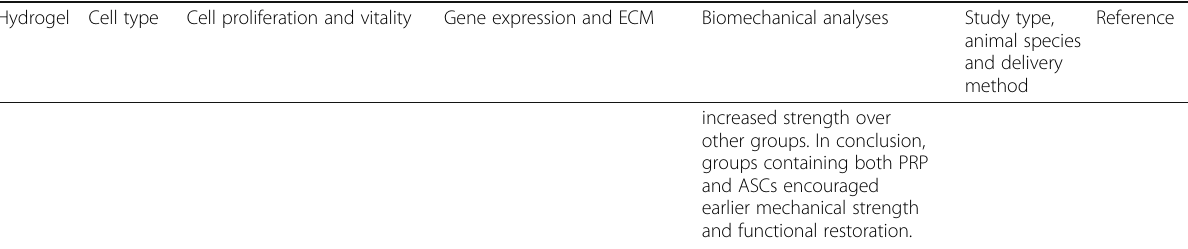
Table 2 Hydrogel-based studies on tendon tissue engineering (Continued) Hydrogel Cell type